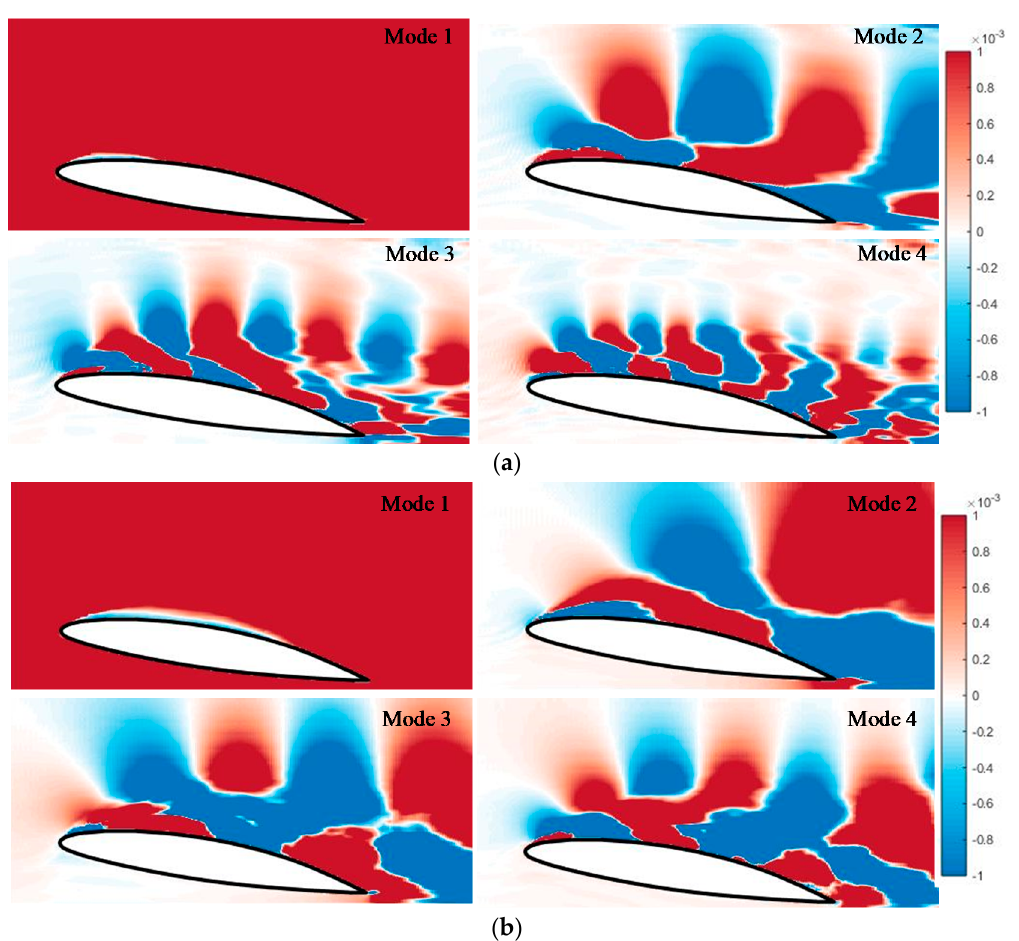
Figure 12. Comparison of the dynamic modes on mid-section plane with free surface and without free surface. ( a ) Dynamic mode near the free surface ( h = 0.25 C ); ( b ) Dynamic mode without free surface.